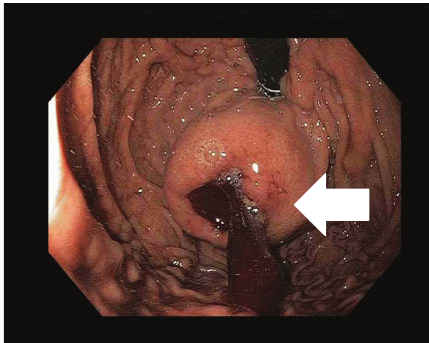
Figure 1: Esophagogastroduodenoscopy (EGD) showing an ulcer- ated submucosal mass in the fundus of the stomach (white arrow).